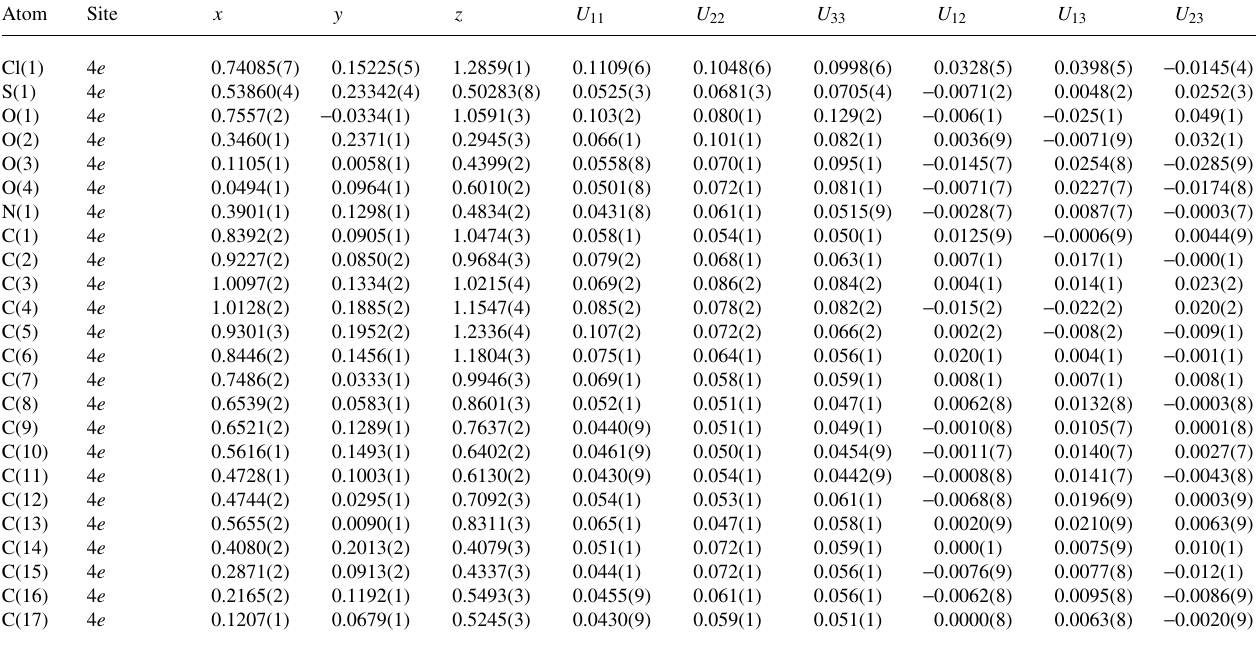
Table 3. Atomic coordinates and displacement parameters (in Å 2 ) .